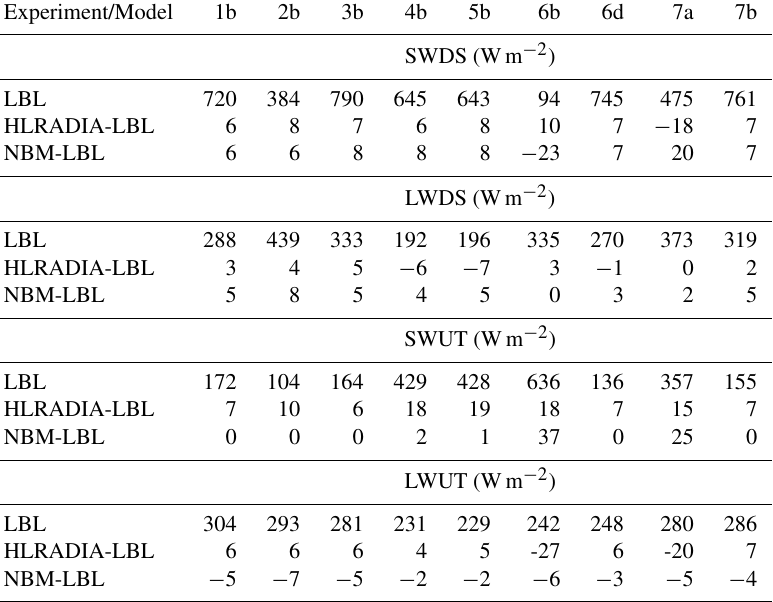
Table 2. LBL surface and TOA SW and LW fluxes and the relative difference between HLRADIA and NBM and LBL: HLRADIA minus LBL, NBM minus LBL. Fluxes out from the atmosphere to the ground (SWDS, LWDS) and space (SWUT, LWUT) are denoted